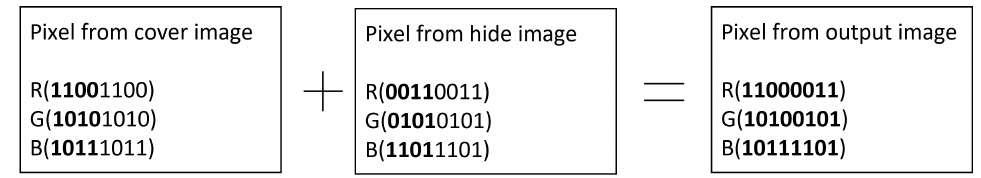
Figure 5. Toy sample for image